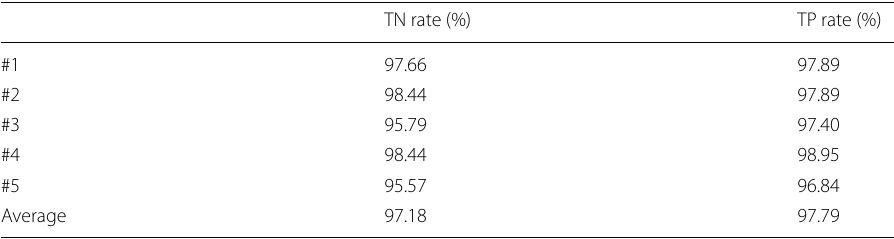
Table 1 Fivefold cross-validation and average detection